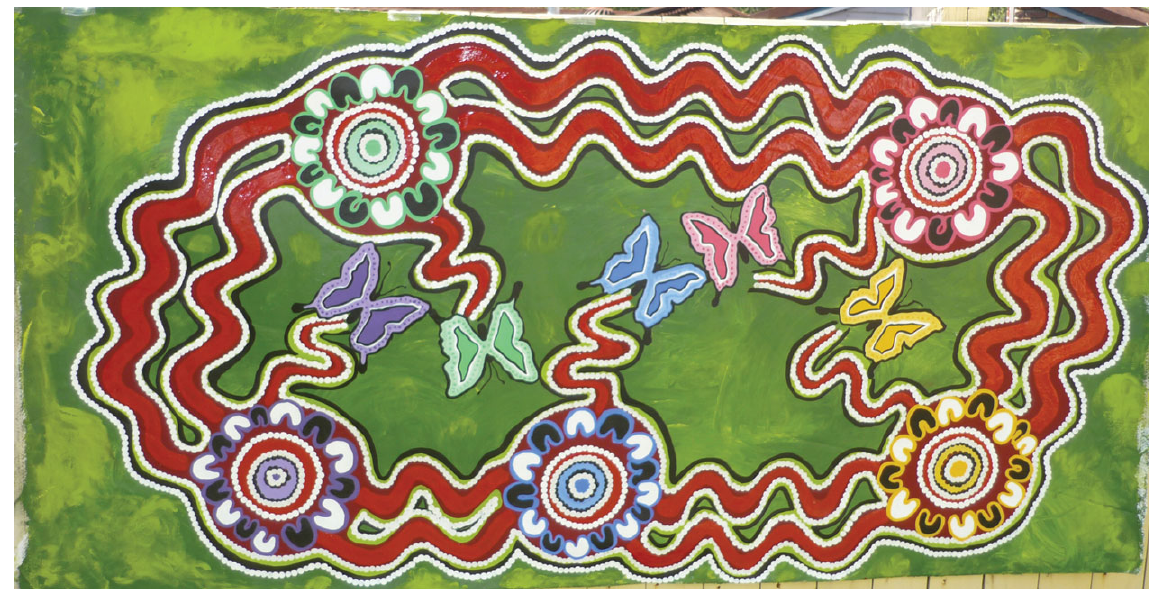
(Colour online) SpreadingyourWings, Denise Proud (2011).